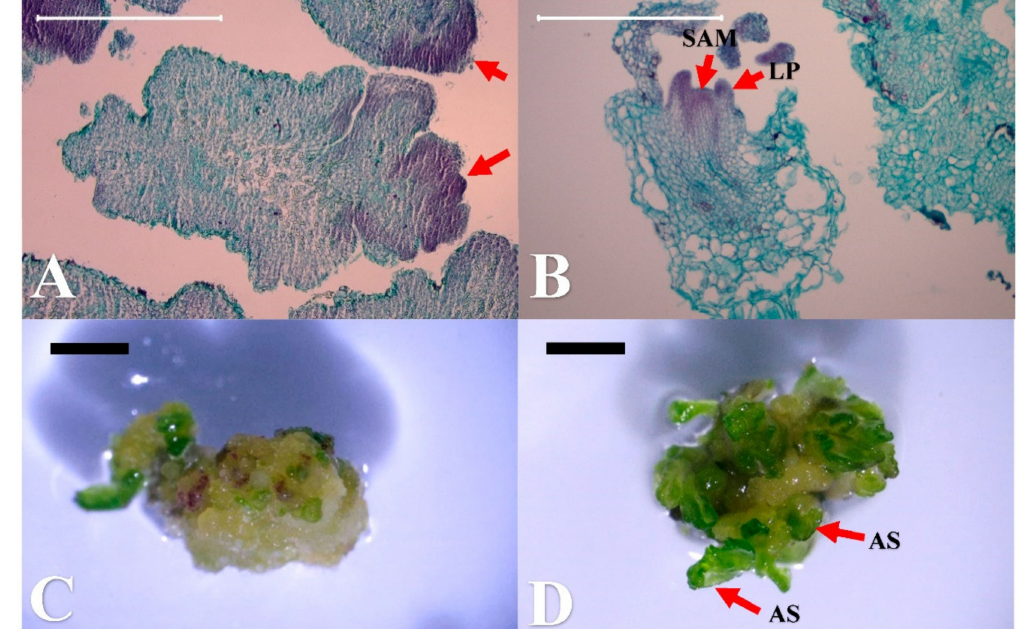
Figure 3. Histological observation of the shoot regeneration from wild strawberry ( Fragaria vesca ) calli after 2 weeks of culturing, with their corresponding development stages (bar). ( A ) Meristematic cells originated from the cells of the callus explants (500 µ m); ( B ) shoot organogenesis with leaf primordium (LP) and shoot apical meristem (SAM) (500 µ m); ( C ) the corresponding developmental stage of the callus explants corresponding to (A) (1 mm); ( D ) the stage of adventitious shoot (AS) development corresponding to (B) (1